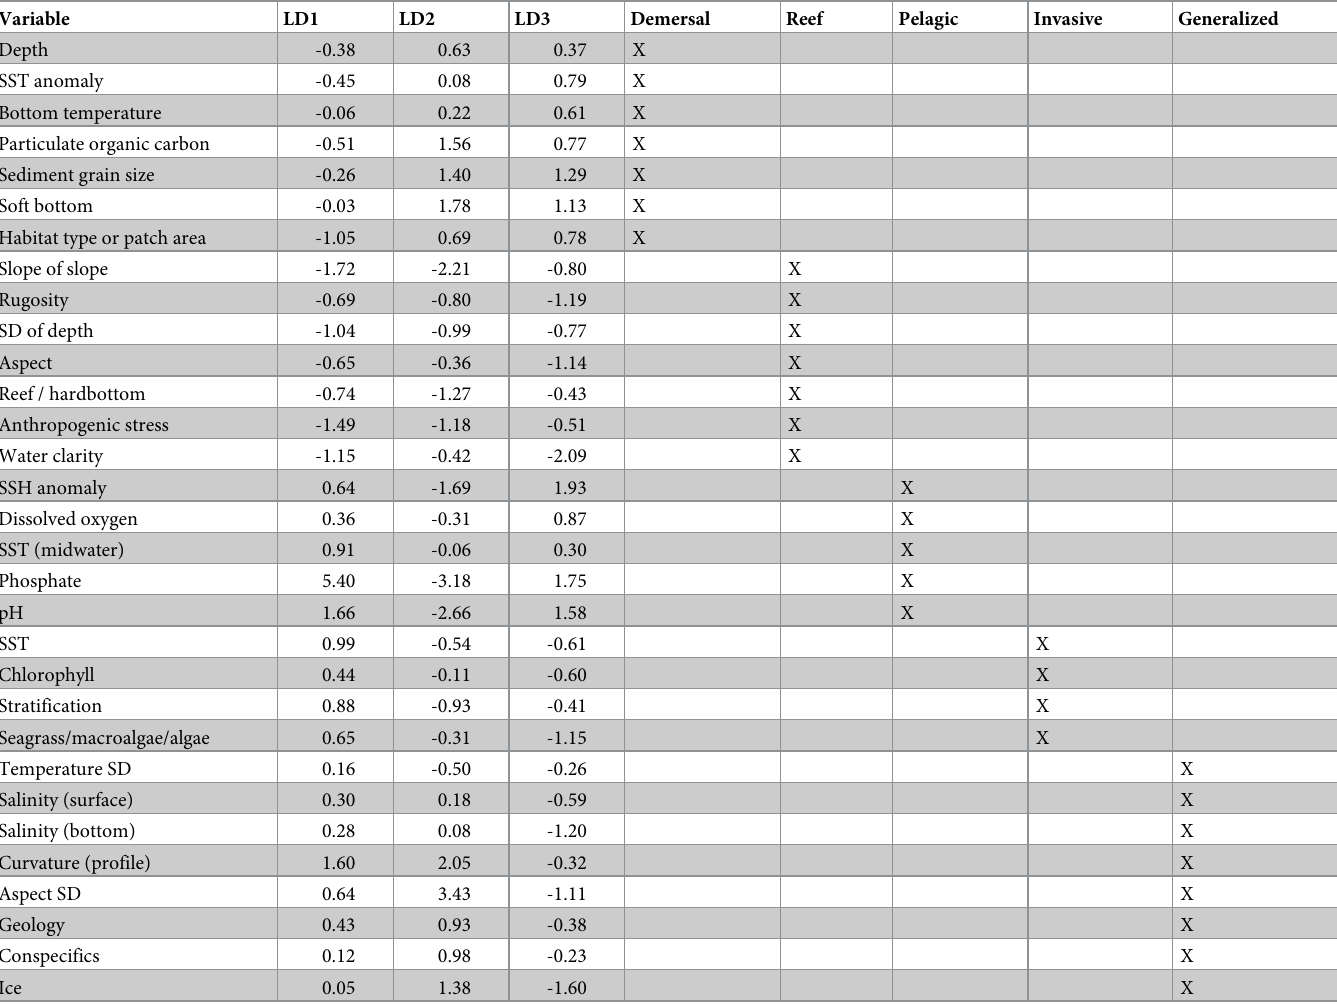
Table 3. Distinguishing predictor variables for each marine fish guild based on a linear discriminant